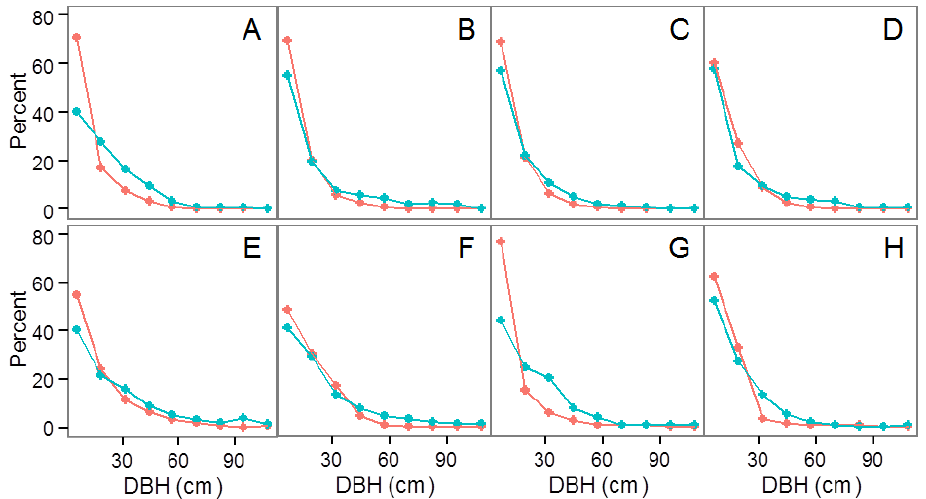
Figure 5. Distribution of trees by diameter at breast height (DBH) and location. Urban forest is in blue, periurban forest is red. ( A ) Winchester, VA; ( B ) Charlottesville, VA; ( C ) Roanoke, VA; ( D ) Abingdon, VA; (E ) Falls Church, VA; ( F ) Atlanta, GA; ( G ) Gainesville, FL; ( H ) East Orlando, FL.